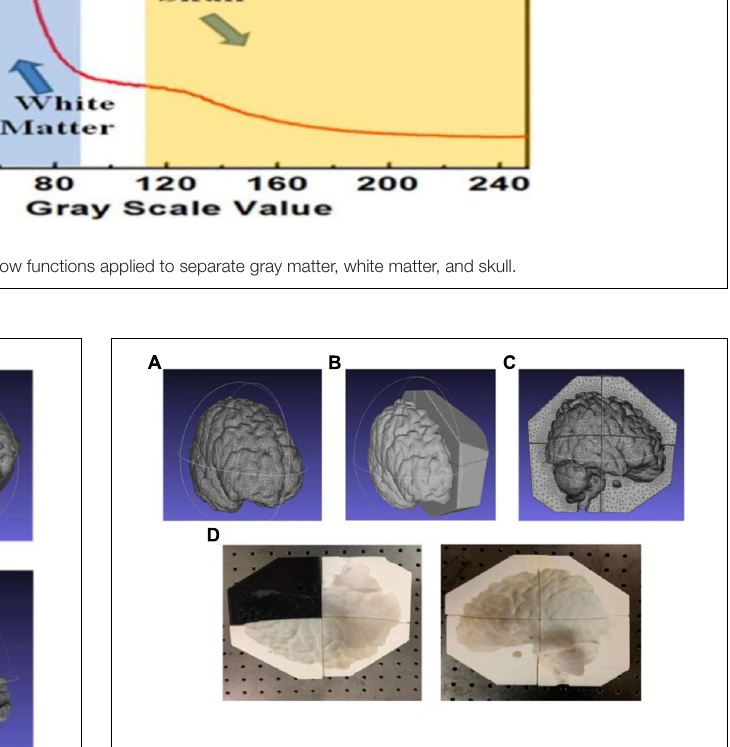
FIGURE 6 | (A–C) The .stl files for the gray matter and (D) printed mold